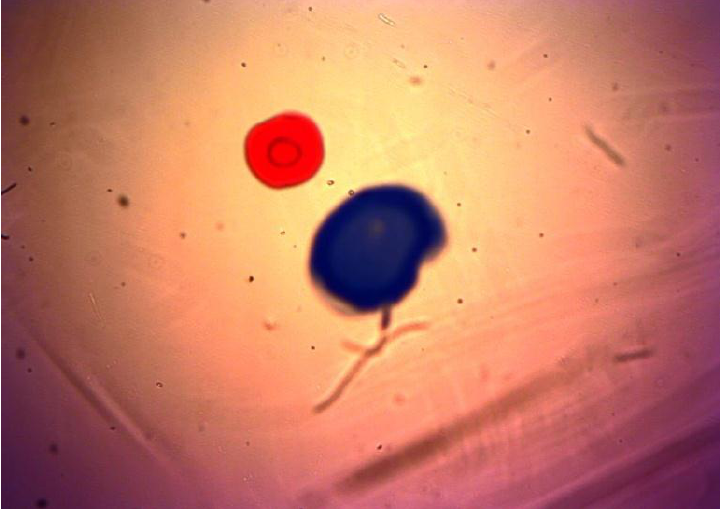
Figure 22. Sensor mounting the Gorilla ® glass disk. Sample is Texaco Meropa (medium absorptivity) and the flow speed is approximately 1.5 L/min. Asides, fibers and particles, non-homogeneity of the sample is evident, which may indicate the presence of other contaminants as varnishes.